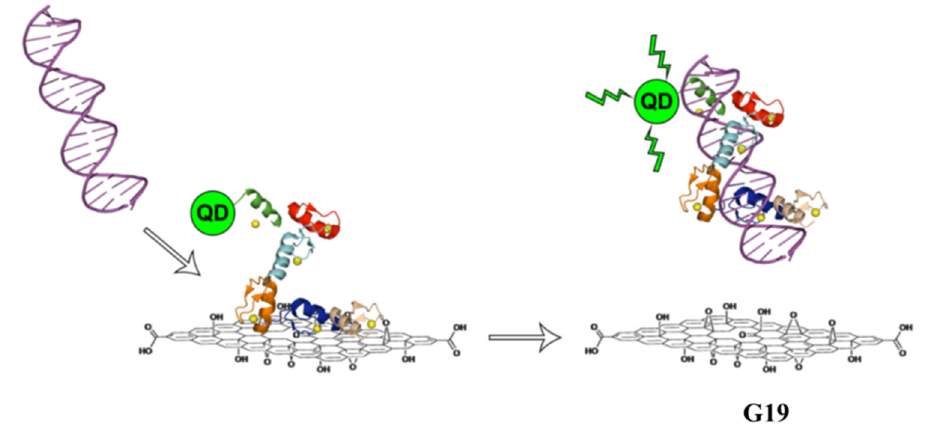
Figure 21. Schematic illustration of the ZFP-GO ( G19 ) FRET system and its dsDNA sensing approach. Reprinted from [76] with permission from the American Chemical Society.